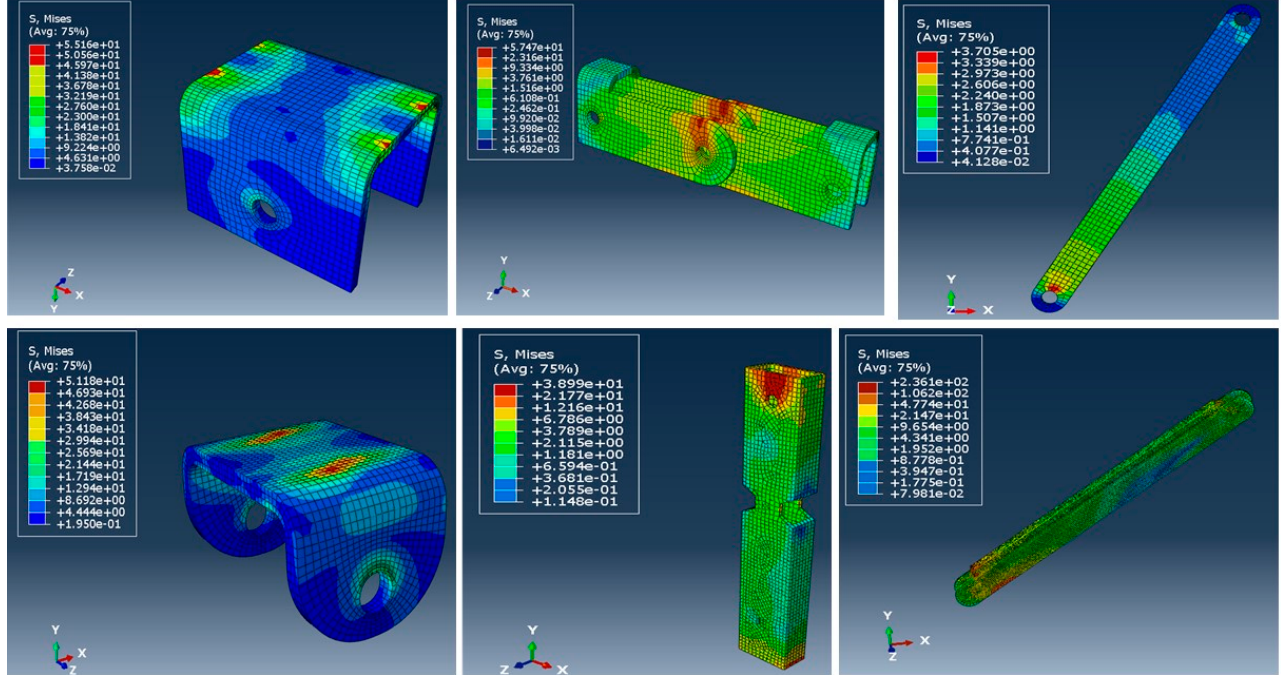
Figure 30. Stress (MPa) contour plot of different parts for a factored gravity load of 4